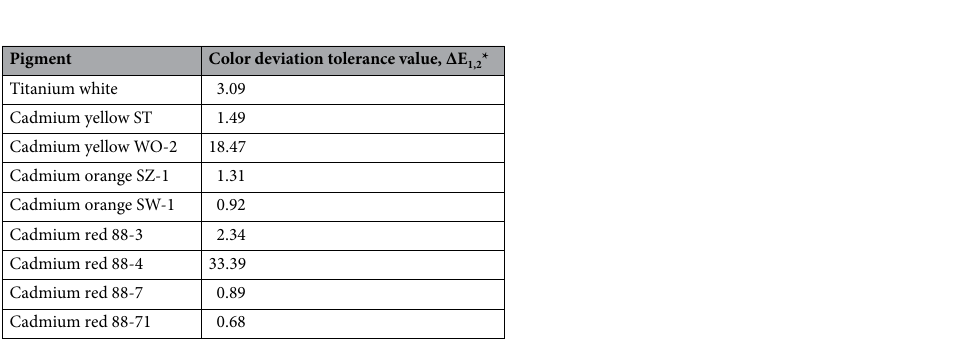
Table 8. Colour deviation tolerance values for coloured PVC membranes, taking into account the influence of UV radiation.